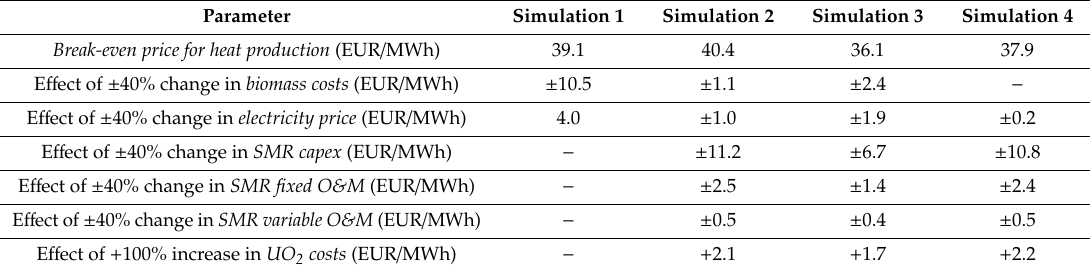
Table 6. Sensitivity of the heat production break-even prices to change in expenditures and the price of electricity.